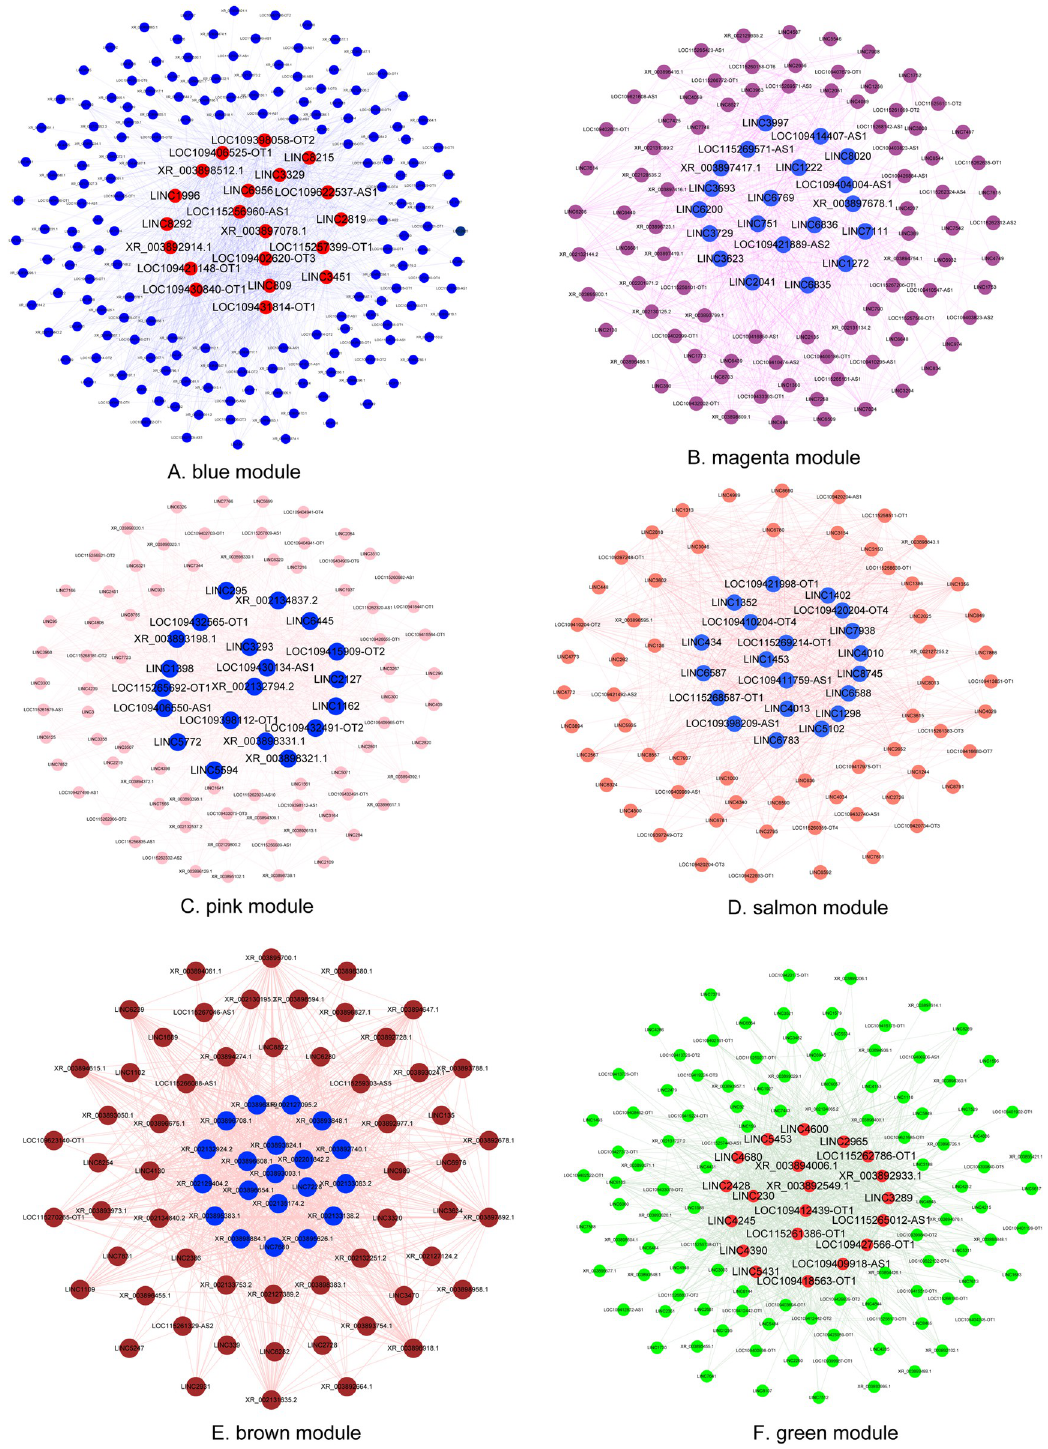
Fig 4. Co-expression network of blue module (A), magenta module (B), pink module (C), salmon module (D), brown module (D) and green module (F). Each node represents a lncRNA, each edge denotes a target relationship between lncRNAs. The top 20 hub genes were showed in red (in blue and green module) and blue (magenta, pink, salmon, and brown module).